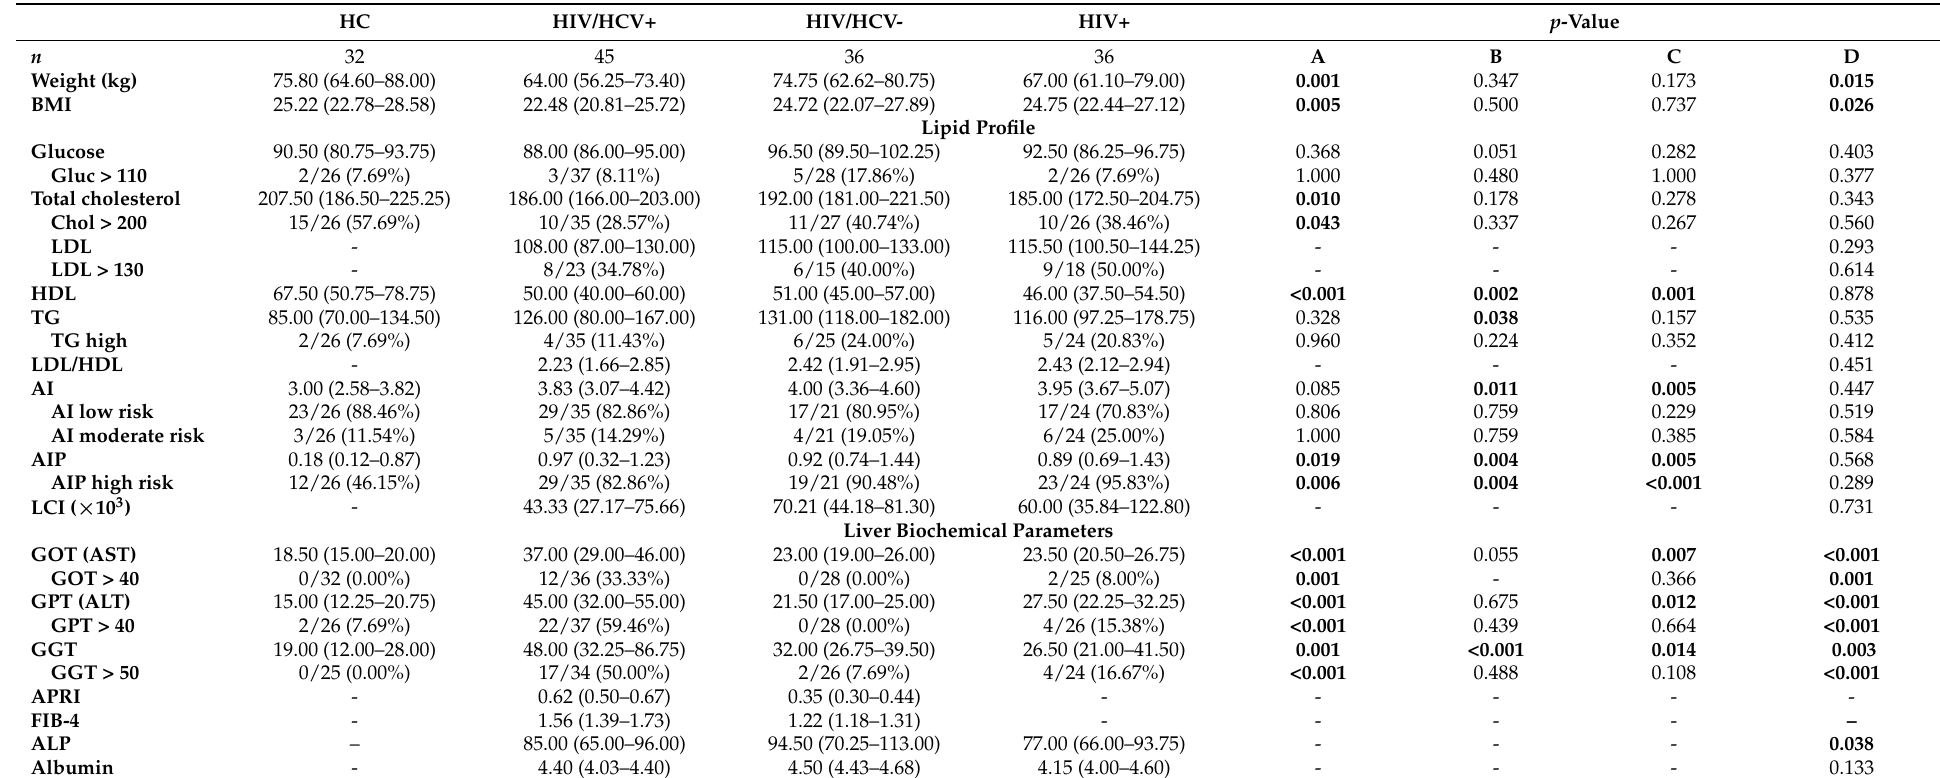
Table 2. Metabolic characteristics of patients enrolled in the study stratified by HCV infection status. Values are expressed as absolute numbers (percentage) and median (percentile 25–percentile 75). p -values were estimated by the nonparametric Kruskal–Wallis test and Mann–Whitney U test for continuous variables and by Fisher’s exact test for categorical variables. The following comparisons were performed: (A) HC vs. HIV/HCV+ group; (B) HC vs. HIV/HCV- group; (C) HC group vs. HIV+ group; (D) HIV/HCV+ vs. HIV/HCV- vs. HIV+. Statistically significant differences are shown in